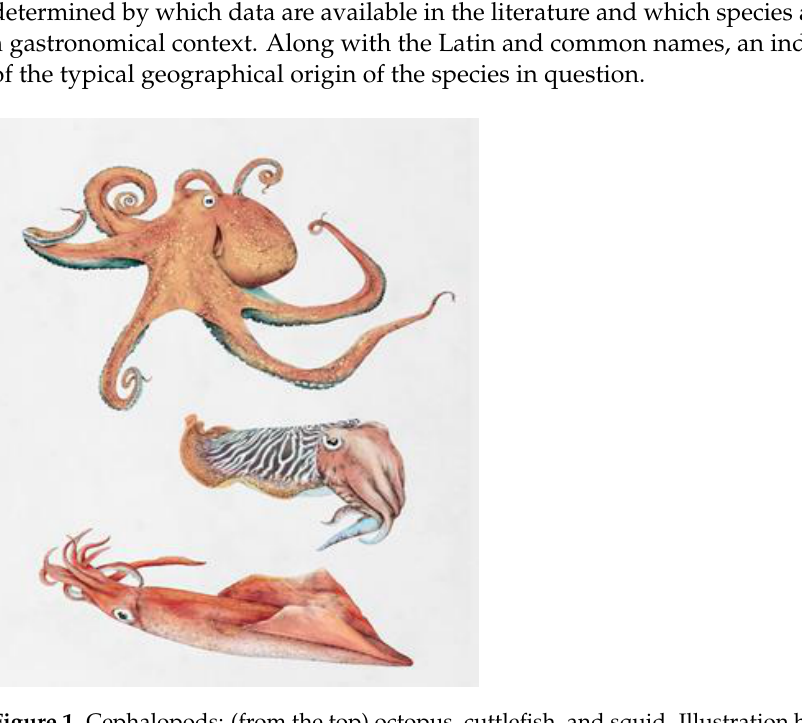
Figure 1. Cephalopods: (from the top) octopus, cuttlefish, and squid. Illustration by Ene Es. Table 1. Overview table of Latin and common names of some common species of